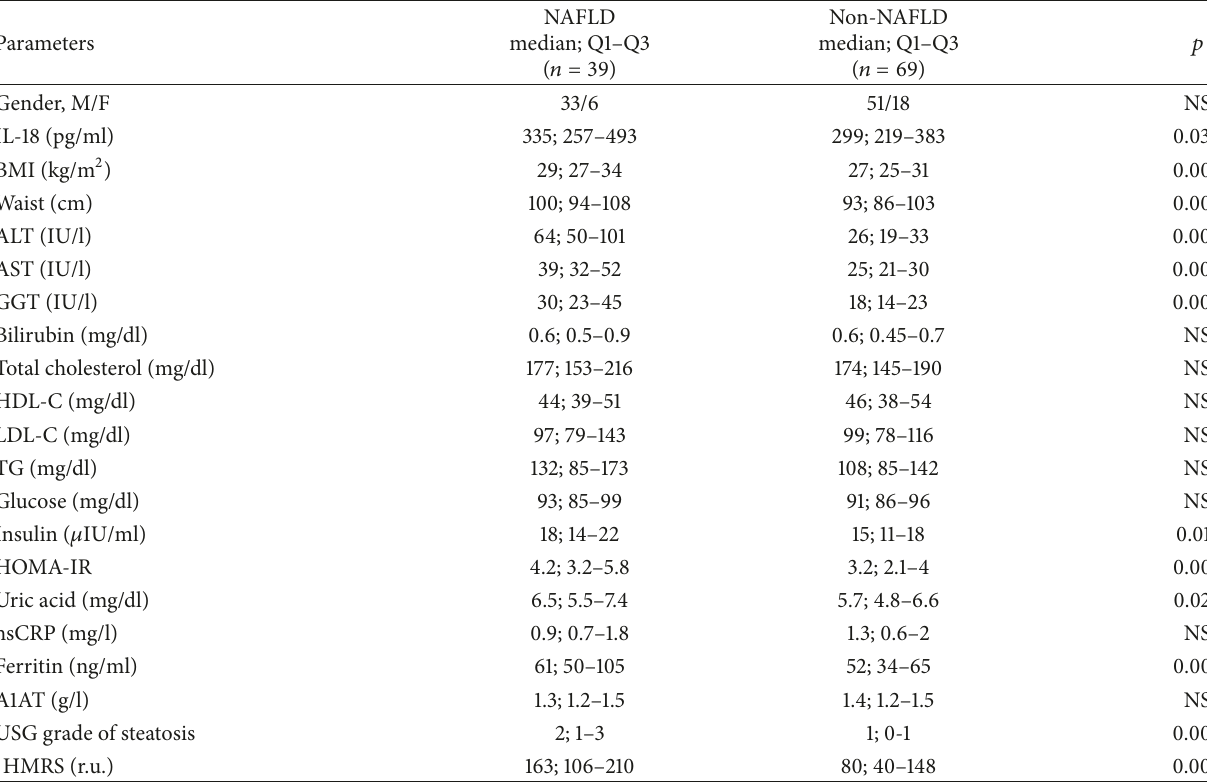
Table 1: Analyzed parameters in all obese patients included in the